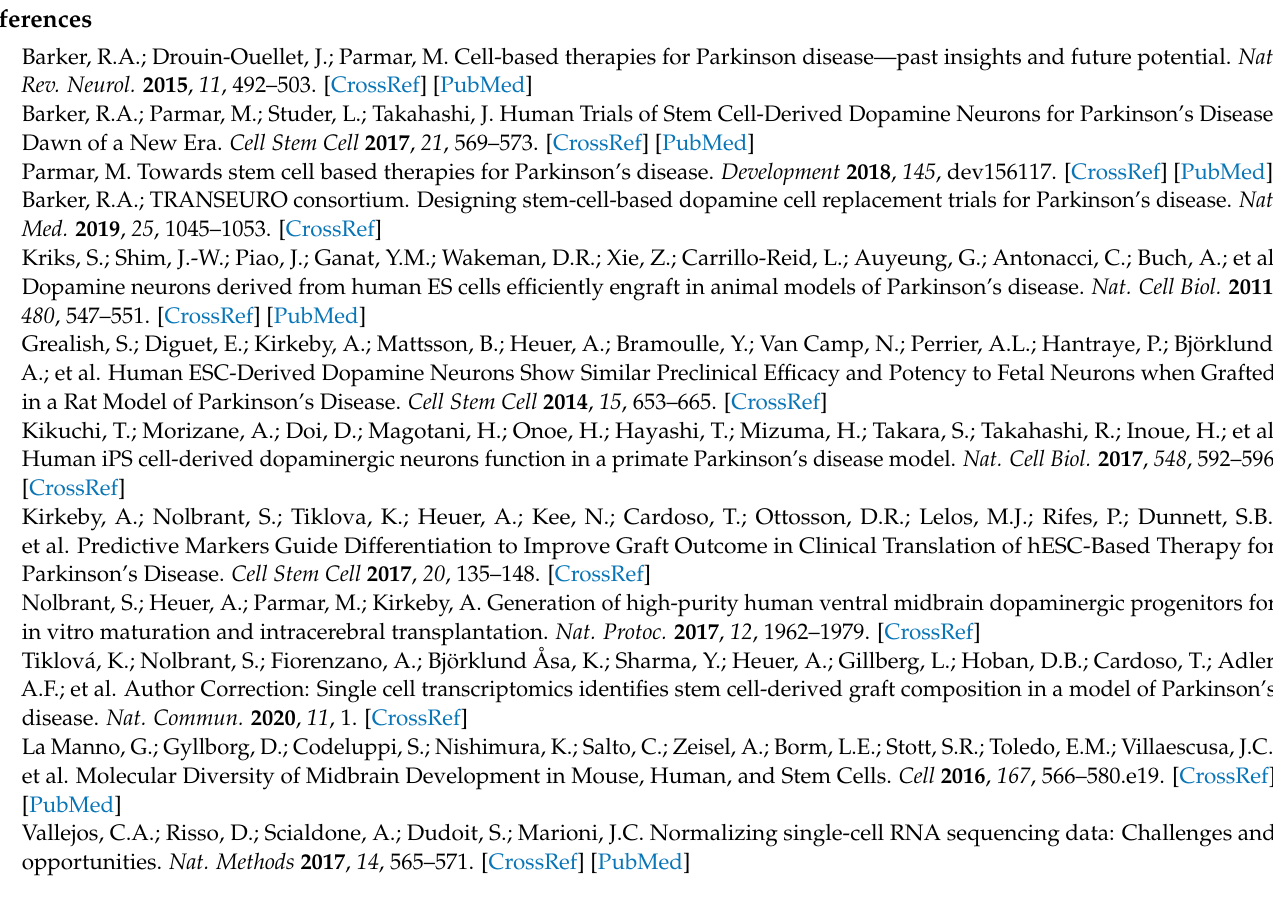
Figure S2: Cell-type identification based on scRNAseq and immunocytochemistry, Figure S3: Differ- entially expressed lncRNAs based on cell-type and time-point, Table S1: RT-qPCR primer list, Table S2: LncRNAs deregulated in 60 vs. 16 time points, and Table S3: LncRNAs deregulated in DA vs. FP